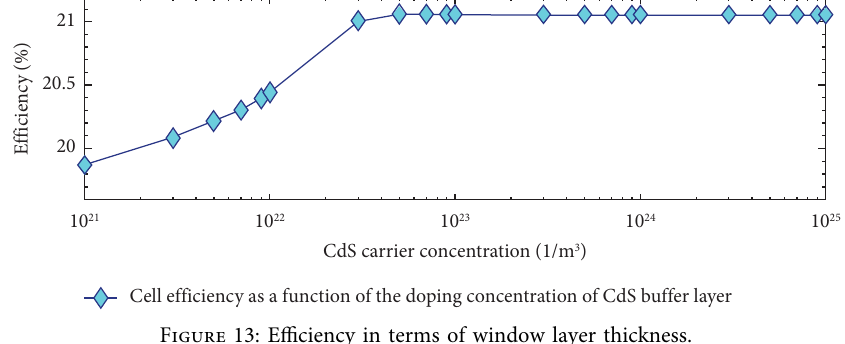
Figure 13: Efciency in terms of window layer thickness.